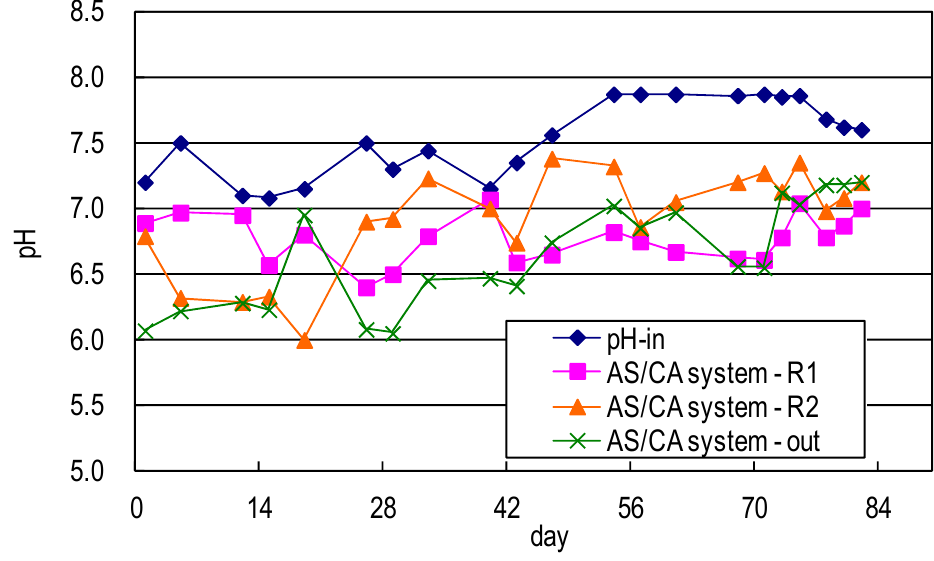
Figure 4. pH value of synthetic domestic sewage treated using AS / CA system.